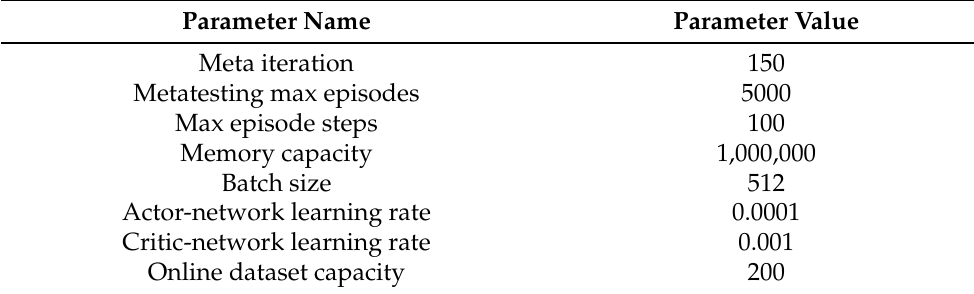
Table 4. Parameters of model training.